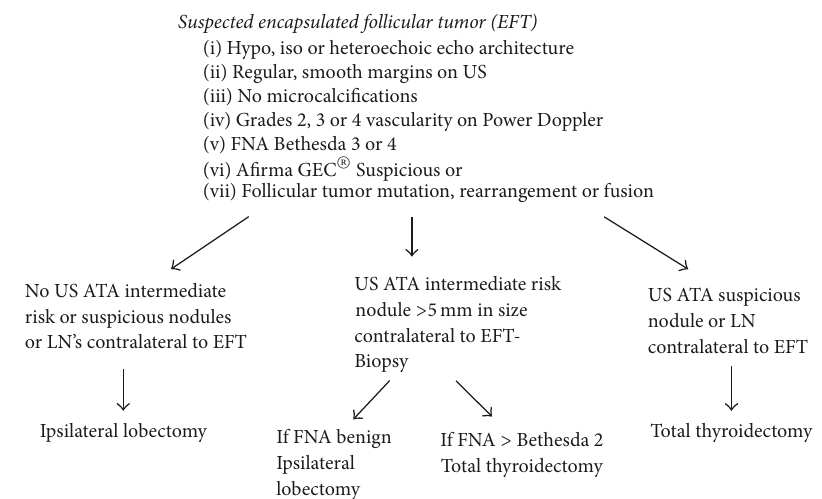
Figure 1: Algorithm for surgical decision-making with suspected encapsulated follicular